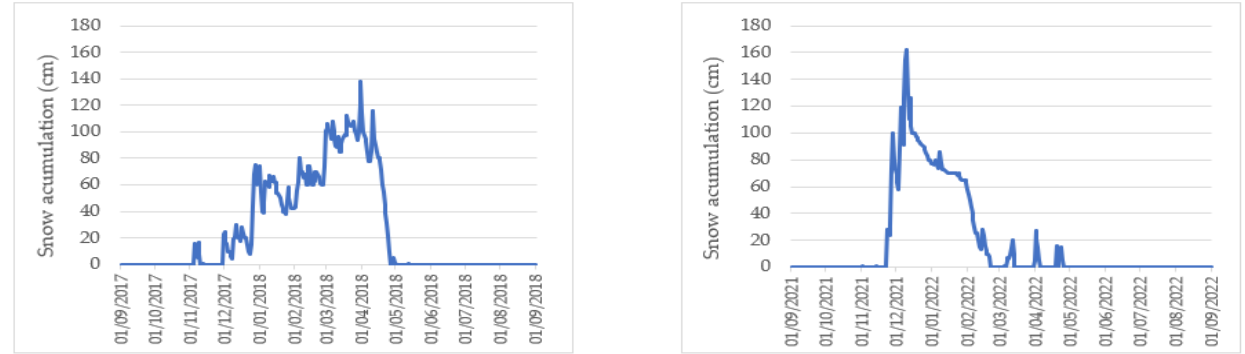
Figure 22. Evolution of snowpack thickness at the Casa de Piedra refuge, weather station (1636 m a.s.l.). Hydrological year 2017/2018 ( left ) and 2021/2022 ( right ). Base data: daily snow depth. Data source: AEMET [50].